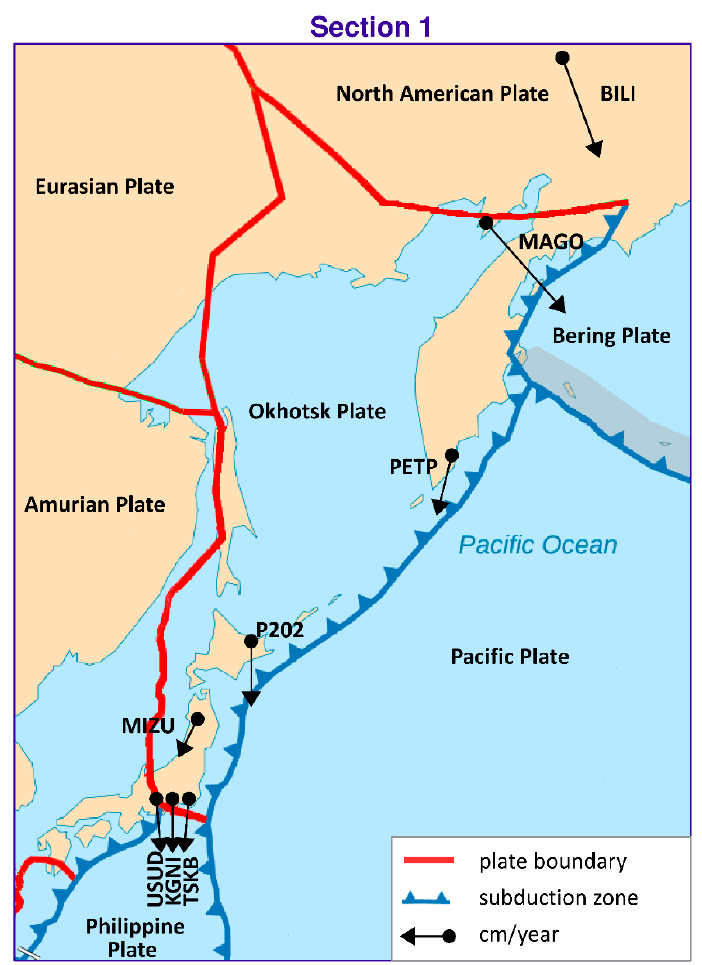
Figure 3. The location and motion of the GNSS stations that are not consistent with the Eurasian plate motion; area of Section 1 (Figure 2).